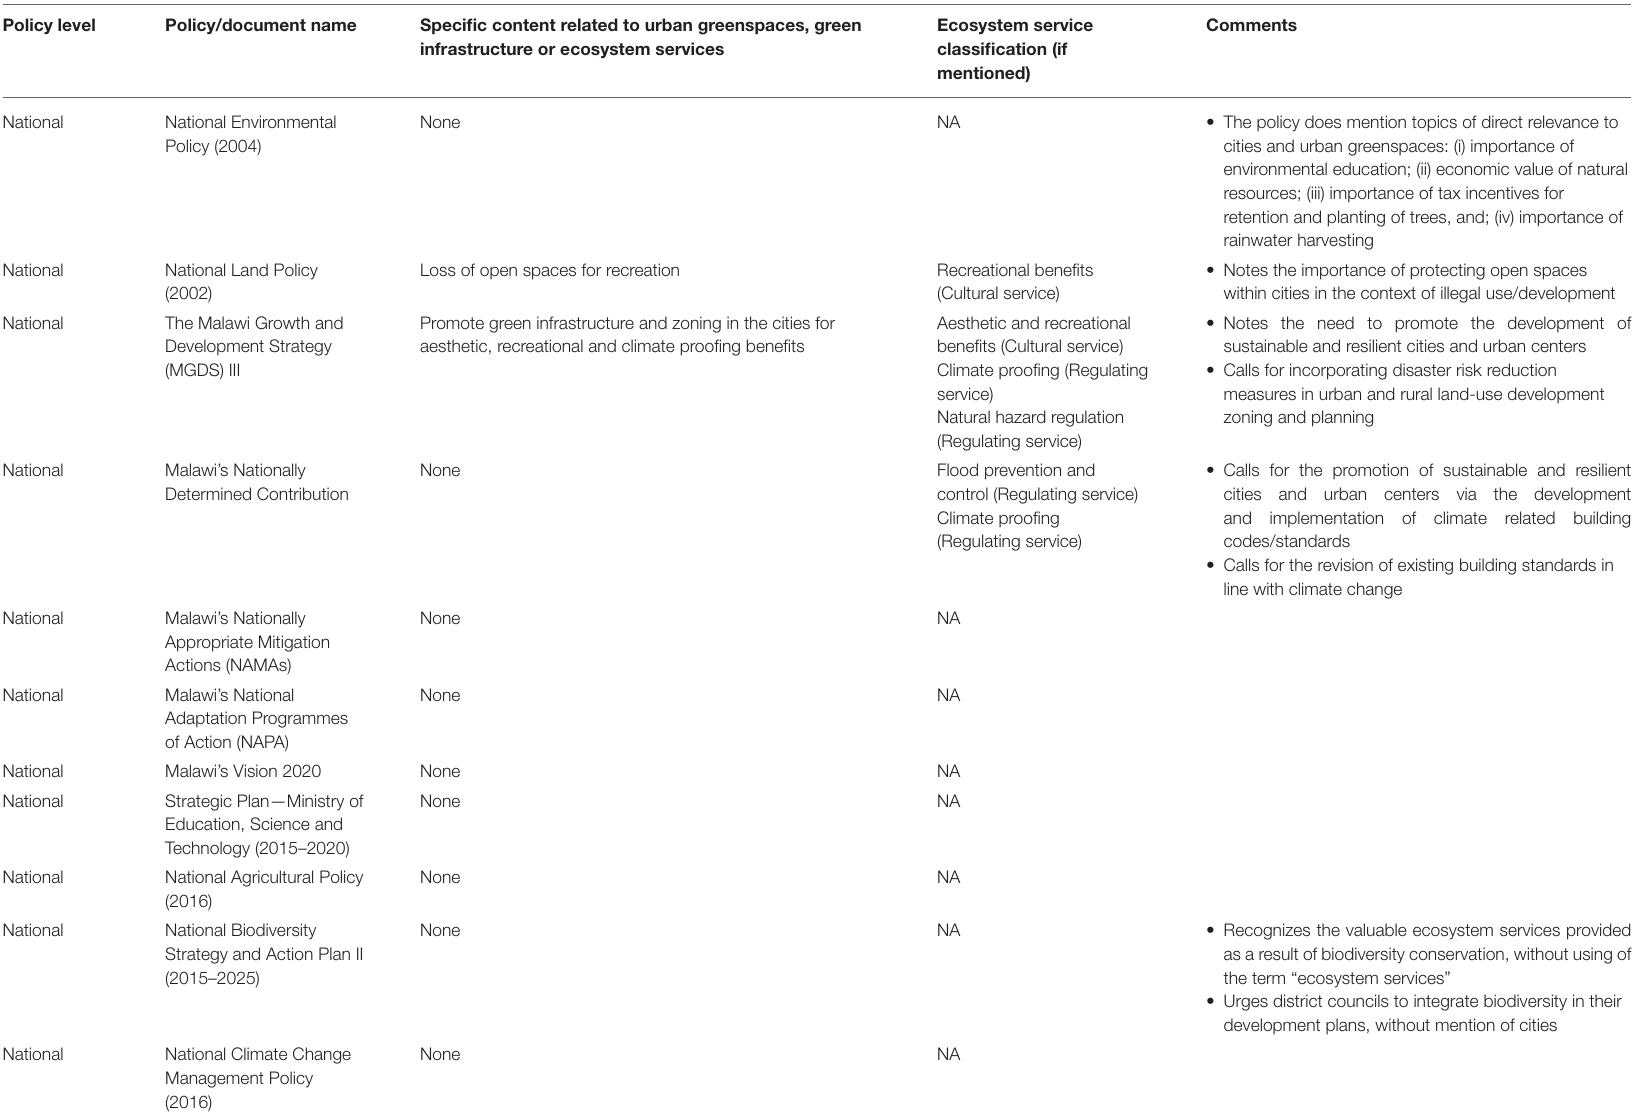
TABLE 1 | Summary of the extent to which policies and documents at the National and City level for Malawi, Lilongwe, and Mzuzu include explicit mention of urban greenspaces, green infrastructure, and associated ecosystem service provision. Policy level Policy/document name Specific content related to urban greenspaces, green infrastructure or ecosystem